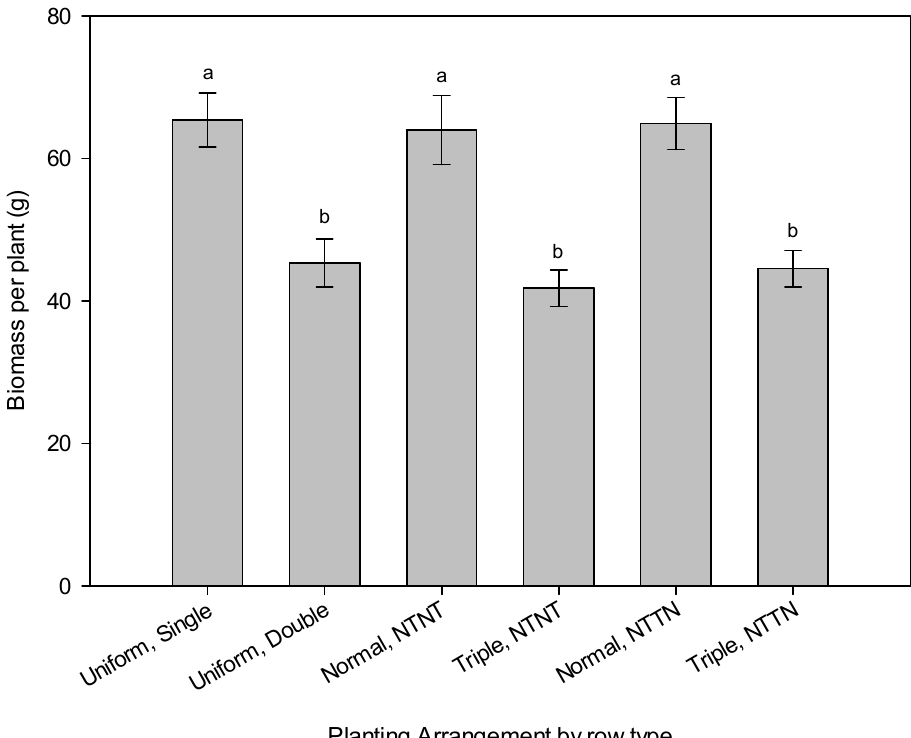
Figure 2. Biomass per plant of soybean grown in rows with normal (N), doubled, and (tripled) in either uniform, NTNT, or NTTN planting arrangements. Bars with different letters indicate significant differences at p < 0.05. Error bars indicate the standard error of the